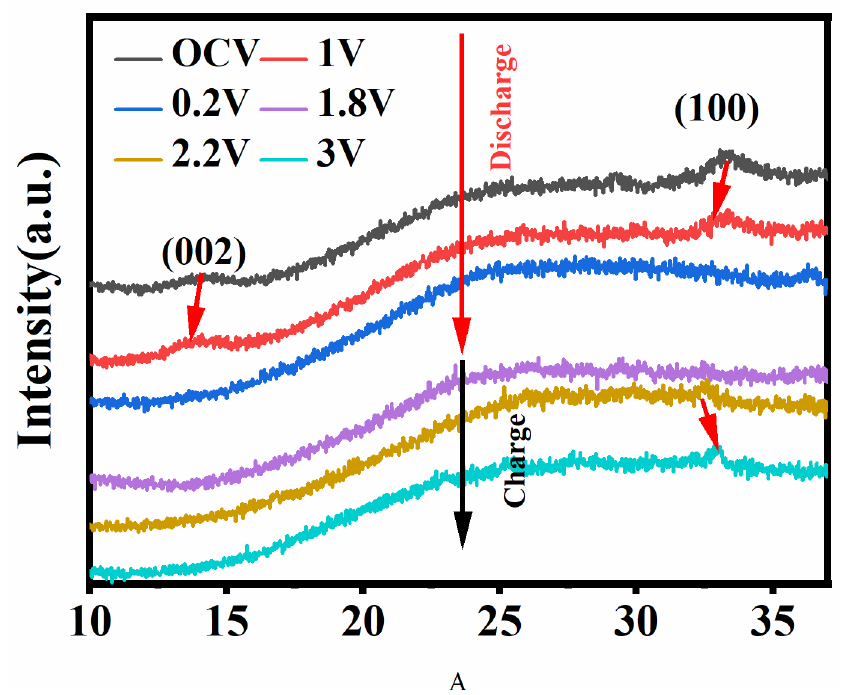
Figure 7. Ex situ XRD patterns of 1T-MoS 2 -600.